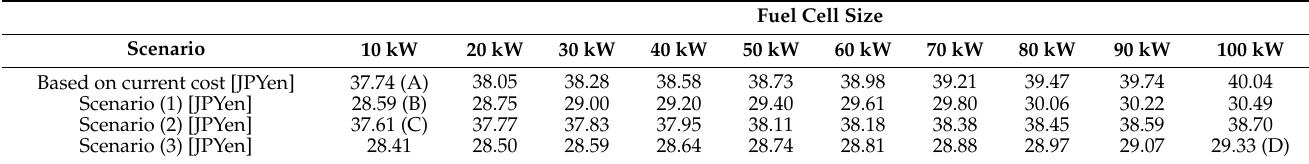
Table 13. Summary of cost of electricity (COE) for each model in the future cost scenario.